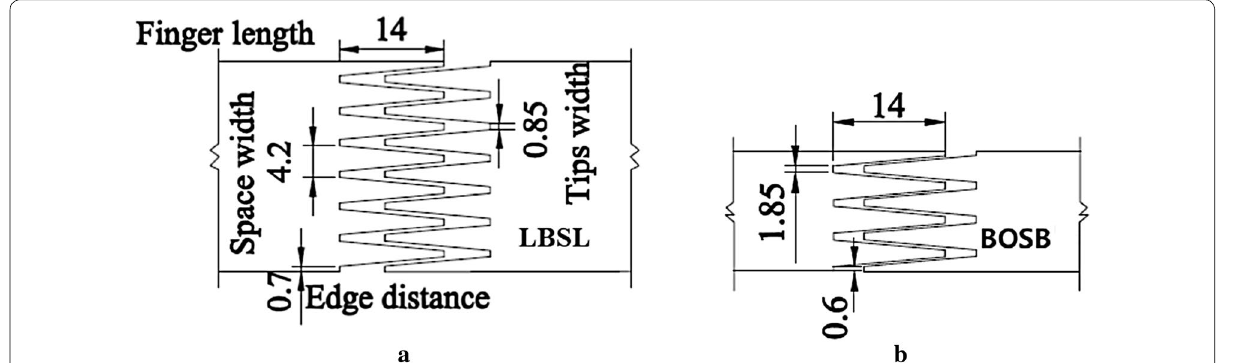
Fig. 1 Flange finger-joint ( a ) and web finger-joint ( b )